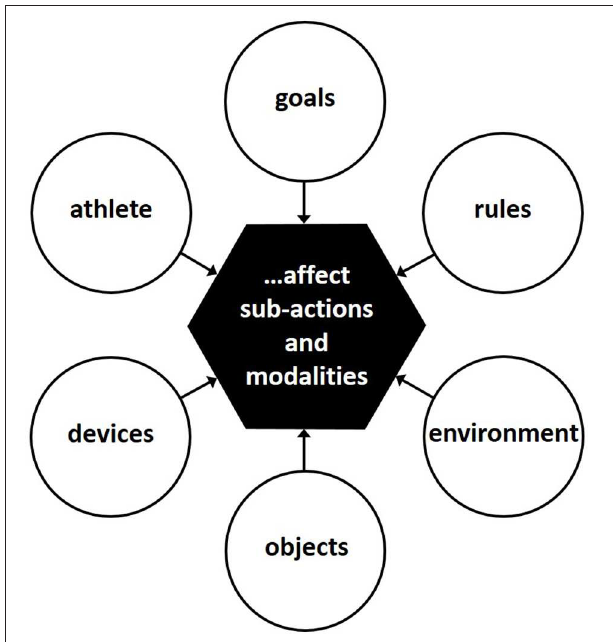
FIGURE 1 | Constraints affecting the identification of a desired value of a sports